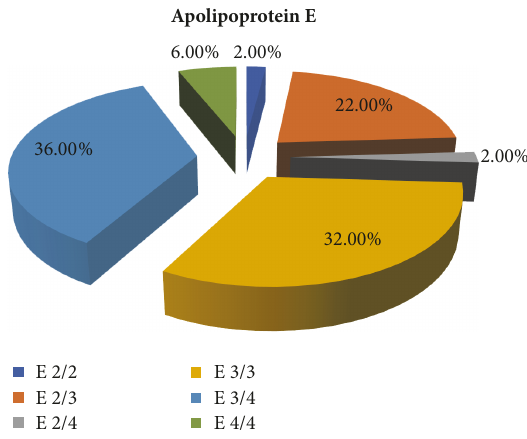
Figure 1: Percentage of different ApoE alleles in all